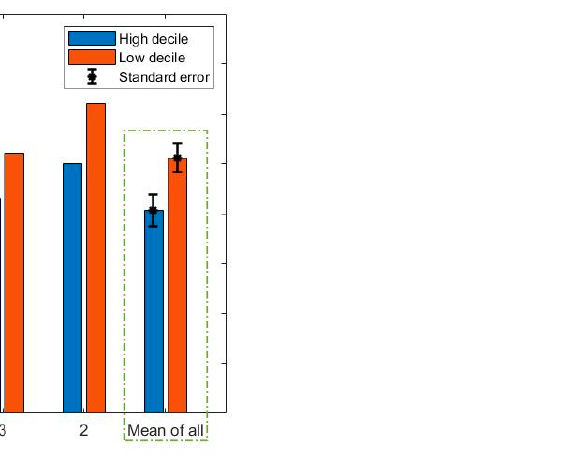
Figure 5. Bar plot of the percentage of old cars (manufactured before 2005) for the roads along each of the school routes.